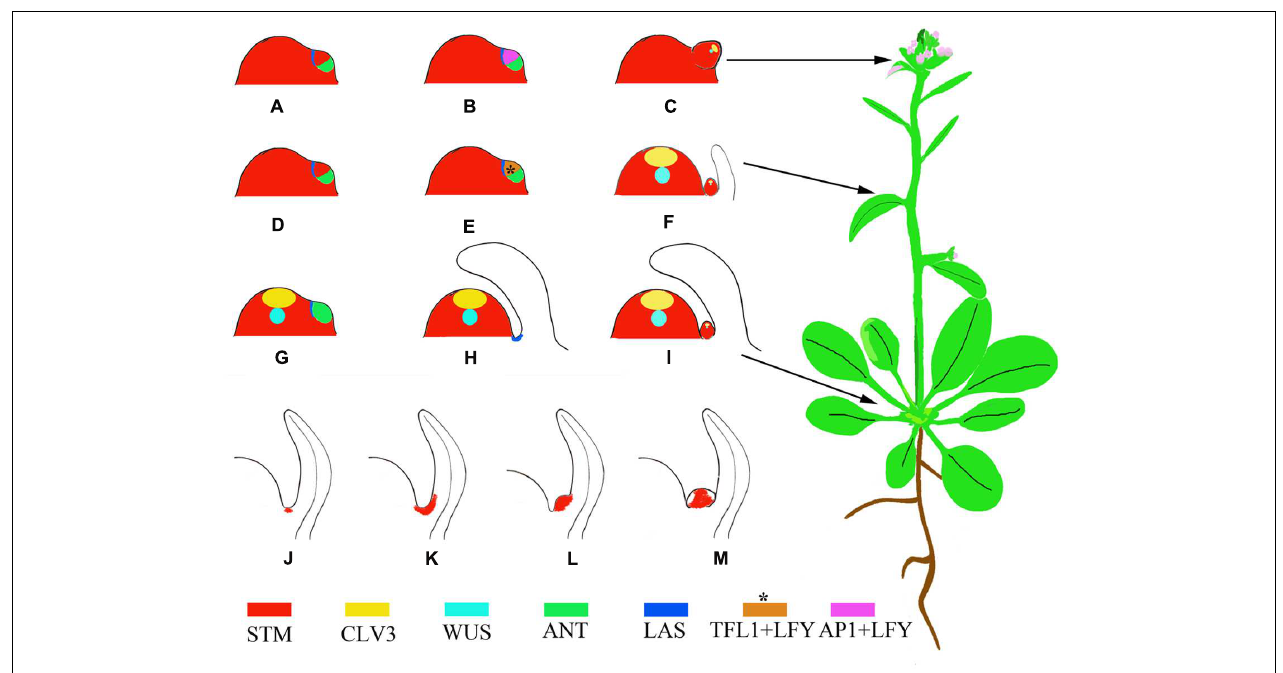
FIGURE 1 | Schematic representation of phytomers with different developmental fates and AM developmental stages marked by the expression of STM . (A–C) A reproductive primordium develops as a bias in the meristem suppresses expression of leaf domain genes. Instead, the meristem maintains STM expression and high levels of LFY and AP1 expression (Grbic, 2005). (D–F) A transitional primordium develops leaf and axillary meristems (AMs) concomitantly. The floral meristem identity gene LFY and the shoot meristem identity gene TFL1 (brown color) are expressed at high levels in this primordium (Ratcliffe et al., 1999), which confers mixed features of both leaf and flower primordia. This primordium develops into a cauline phytomer. (G–I) A vegetative primordium develops with the leaf domain prevailing, due to biases toward leaf fate, resulting in a rosette phytomer. (J–M) AM initiation in the leaf axils. The blank region of (M) without STM expression indicates primordium initiation. Asterisks indicate that the expression pattern is postulated and not verified by experiments.